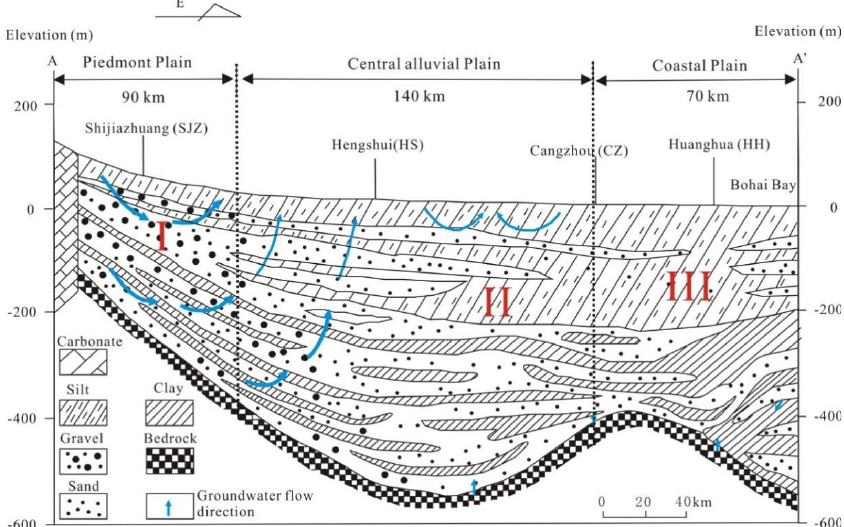
Figure 2. Conceptual cross-section along the A-A ’ line (modified after [28,33,36]). General features of the representative regions are shown in Table 1. For the piedmont